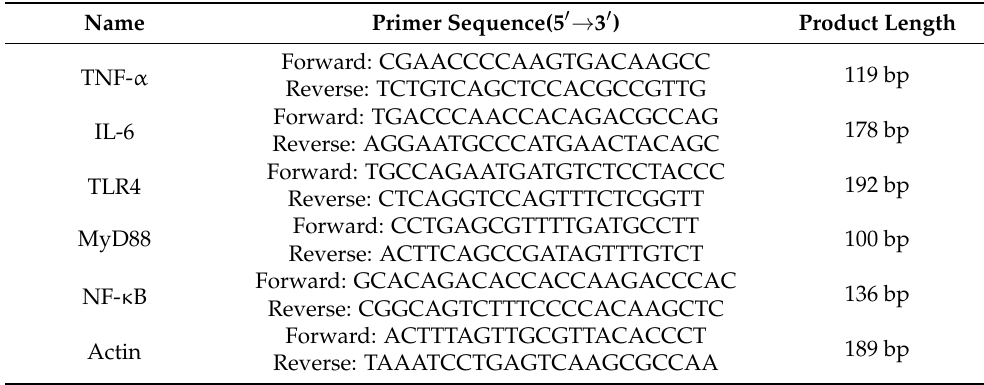
Table 3. Primer sequence and product length for each